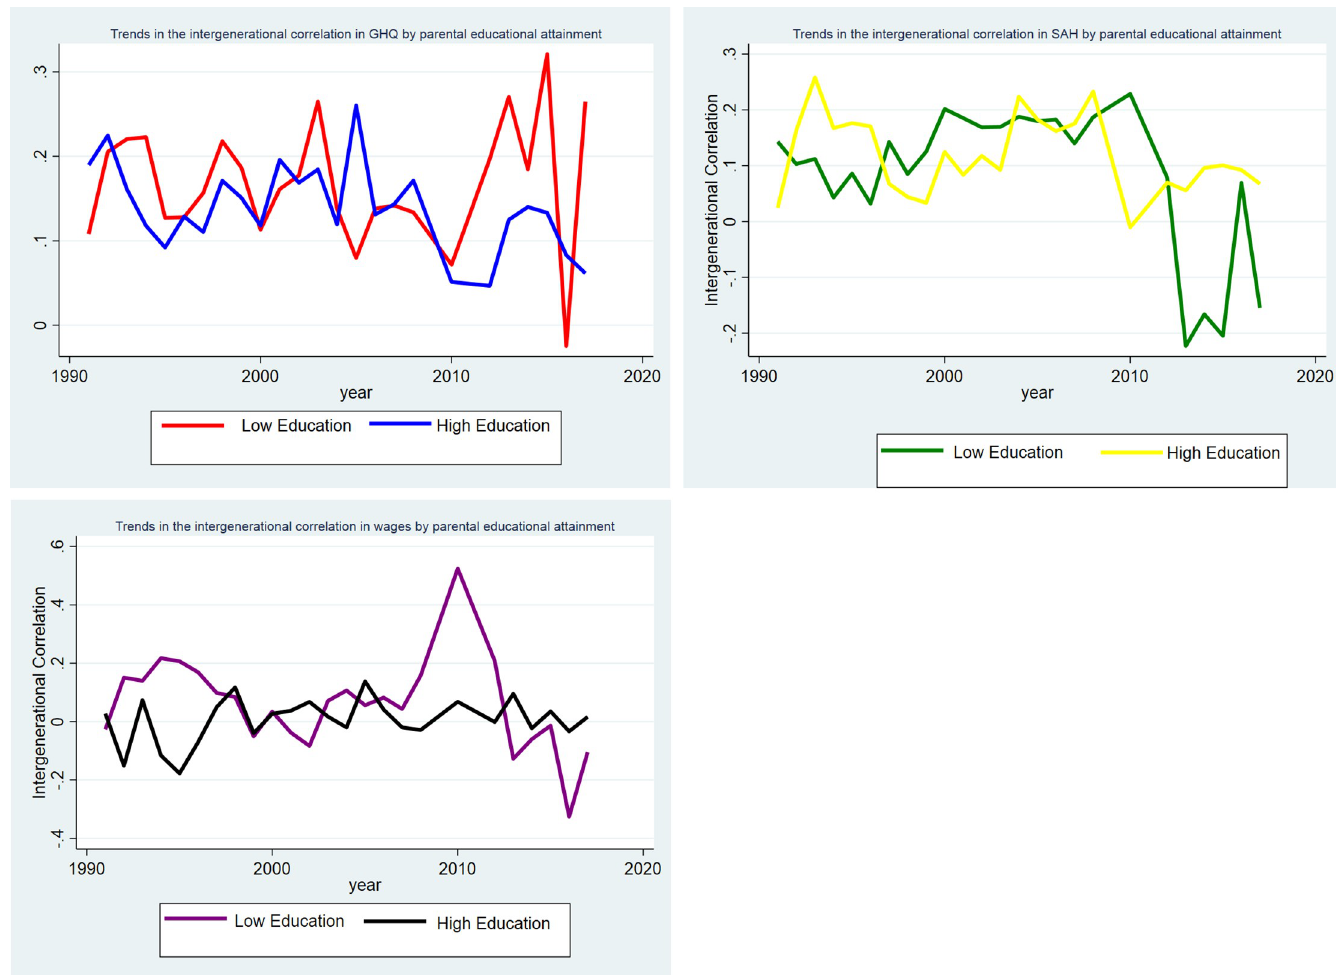
Fig 3. A: Trends in the intergenerational correlation in GHQ between 1991–2017 by parental educational attainment. B: Trends in the intergenerational correlation in SAH between 1991–2017 by parental educational attainment. C: Trends in the intergenerational correlation in log of hourly wages between 1991–2017 by parental educational